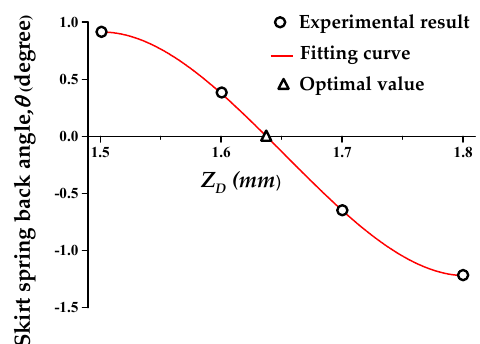
Figure 9. Optimal Z D for compensation of skirt spring-back.